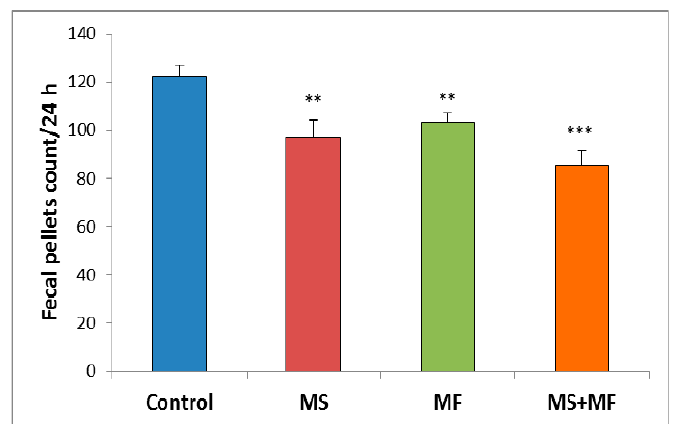
Figure 2. The e ff ect of various combinations of stress factors on gastrointestinal tract habits, as given by fecal pellets count per 24 h. The values are mean ± S.E.M ( n = 10 per group, ** p < 0.01, *** p < 0.001, MS = maternal separation, MF = multifactorial stress.